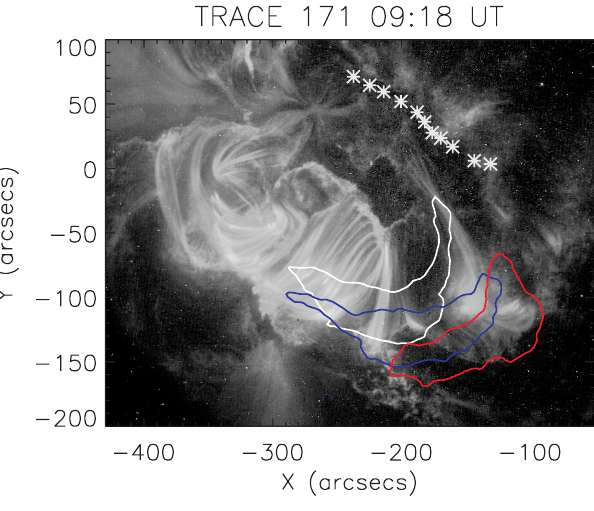
Fig. 5. TRACE 171 ˚A post-flare arcade at 09:18UT overlaid with the same filament contour lines as described in Fig. 4 (white is the MLSO contour line). The white asterisks give the location of the northern filament which did not